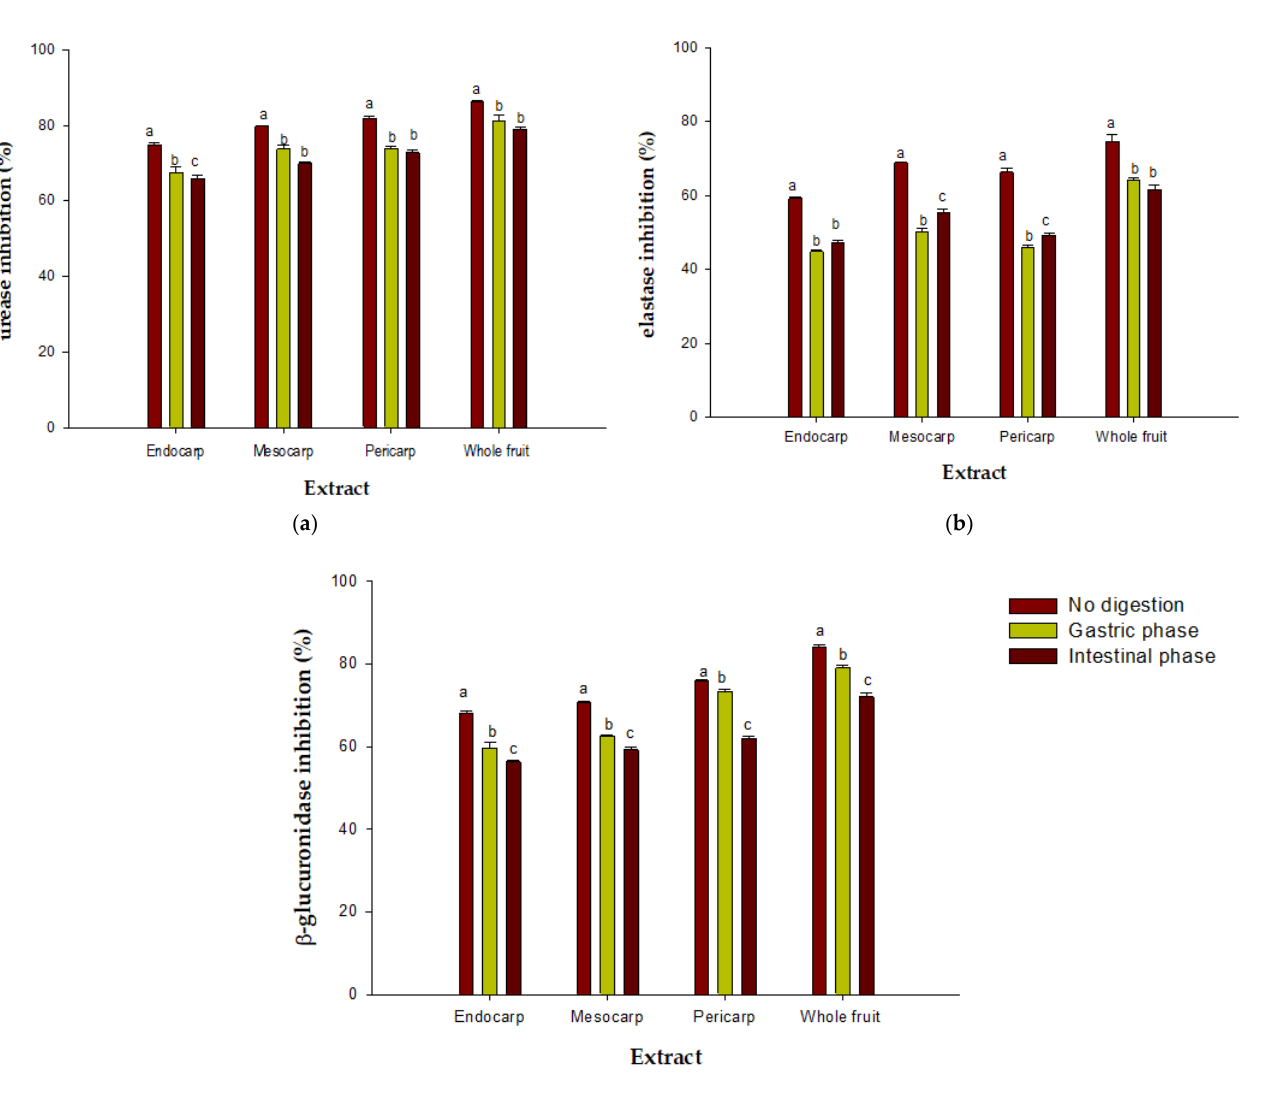
Figure 4. Gastroprotective ( a ), anti-inflammatory ( b ), and hepatoprotective ( c ) bioactivity of the aqueous extract of xoconostle after an in vitro gastrointestinal. The lowercase letters a, b, c, in the columns indicate that there are significant differences ( p < 0.05) between the samples in the undigested phase, gastric phase, and intestinal phase of the simulated digestion.